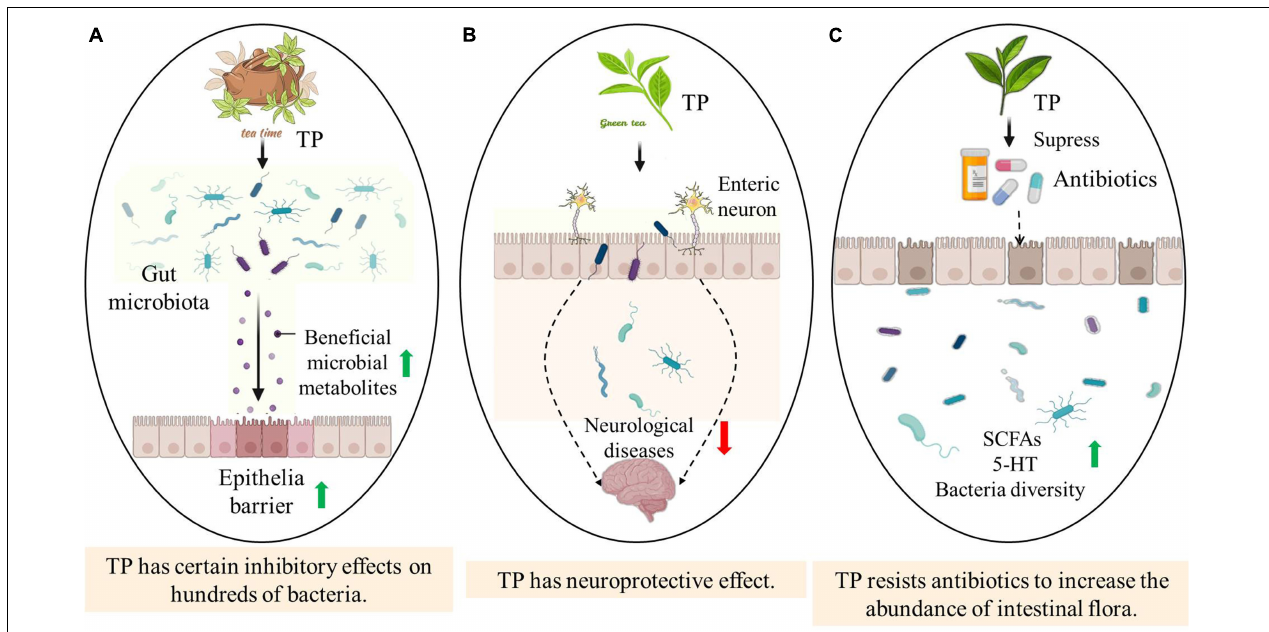
FIGURE 1 | The impact of the multiple biodiversity of tea polyphenols on the host. Panel (A) describes that when tea polyphenols is ingested by the host, tea polyphenols interacts with intestinal flora, thereby increasing some beneficial metabolites that enhance the epithelial barrier and thus resist pathogenic bacteria. Panel (B) shows that TP has a certain regulatory effect on the enteric nervous system, so as to prevent, cure or at least alleviate neurological diseases. As shown by Panel (C) , TP significantly increases the richness and diversity of intestinal flora after antibiotic treatment, improves the imbalance of intestinal flora, and increases the level of SCFAs and